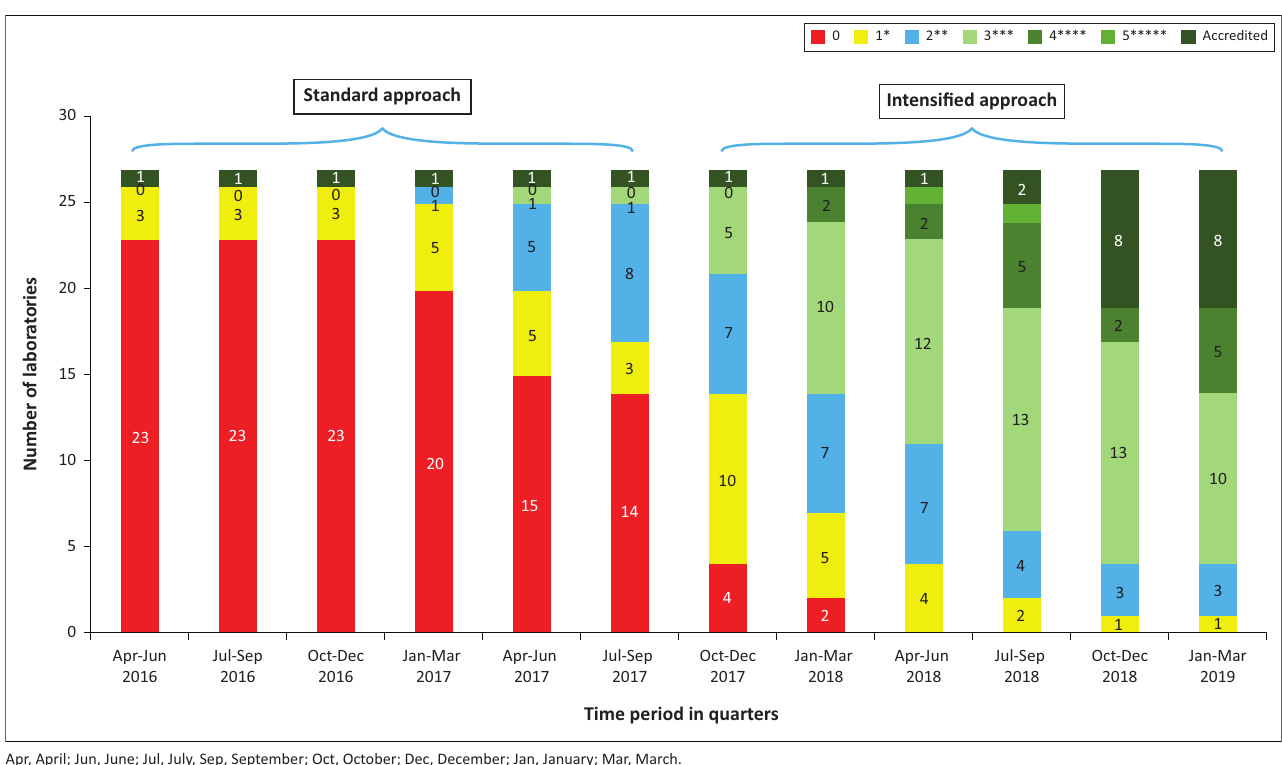
FIGURE 4: Audit star ratings comparison between the standard and intensified mentorship approach for University of Maryland, Baltimore-supported laboratories from April 2016 to March 2019,